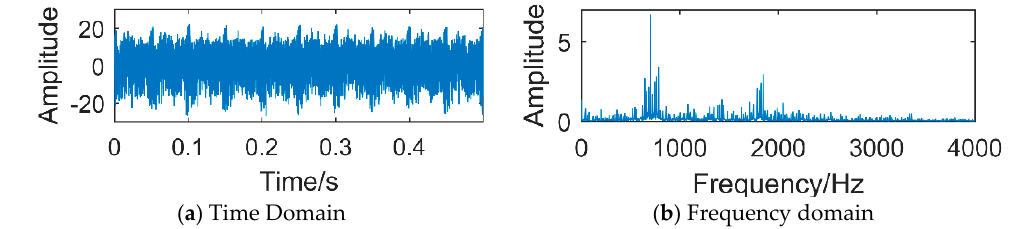
Figure 27. The vibration signals collected by sensors.